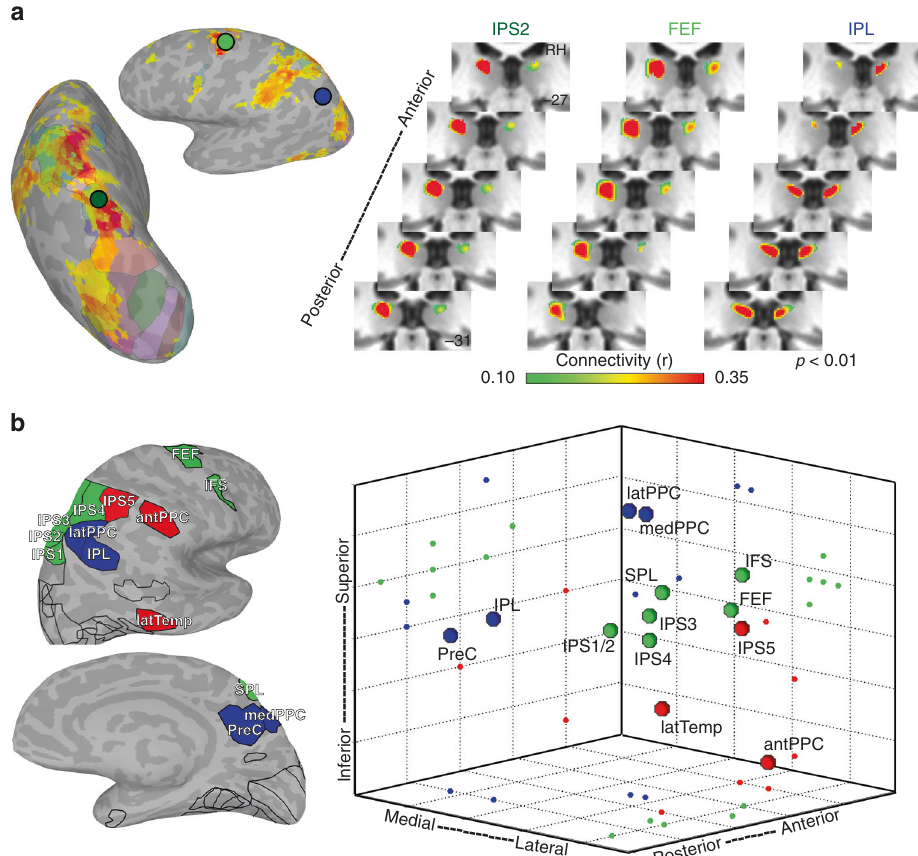
Fig. 5 Functional coupling with dorsal pulvinar. a Group average ( n = 13; p < 0.01 from one-sample t test across subjects) correlations within the dorsal pulvinar for three cortical seed areas (IPS2 (dark green), FEF (light green), and IPL (blue)). Surface fi gures illustrate the cortical correlation patterns from seed in IPS2 in a single subject. Circle colors correspond to area labels for functional coupling with dorsal pulvinar. b Three-dimensional plot of cortical connectivity map peaks in the dorsal pulvinar. Peak coordinates from the left hemisphere were re fl ected across the midline and averaged with the right hemisphere. Spheres depict the 3D spatial location of each area ’ s peak connectivity within the dorsal pulvinar. 2D projections of each data point are plotted on the walls and fl oor of the graph. Pulvino-cortical connectivity within the dorsal pulvinar was clustered into three groups. Within the largest cluster (green) containing the IPS1-4, FEF, and IFS, connectivity re fl ected cortical distance with IPS1/2 located most posteriorly, followed by IPS3/4 and then FEF and IFS located anterior. The peak connectivity for SPL, which is located medial to the IPS maps cortically, was located medial to the IPS1-4 peak correlations in the pulvinar. A second cluster (red) contained tool-selective regions in anterior parietal and lateral temporal cortex as well as IPS5. The third cluster (blue) contained medial, lateral, and inferior parietal areas as well as the precuneus. Surface fi gures illustrate the outlines of all cortical areas tested and color fi lled areas correspond to those included in the clustering of the dorsal